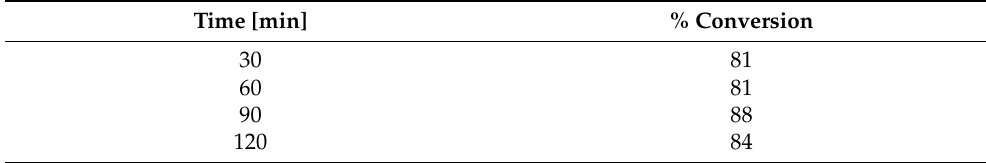
Table 5. Results for kinetic tests with CNS-Cu a .